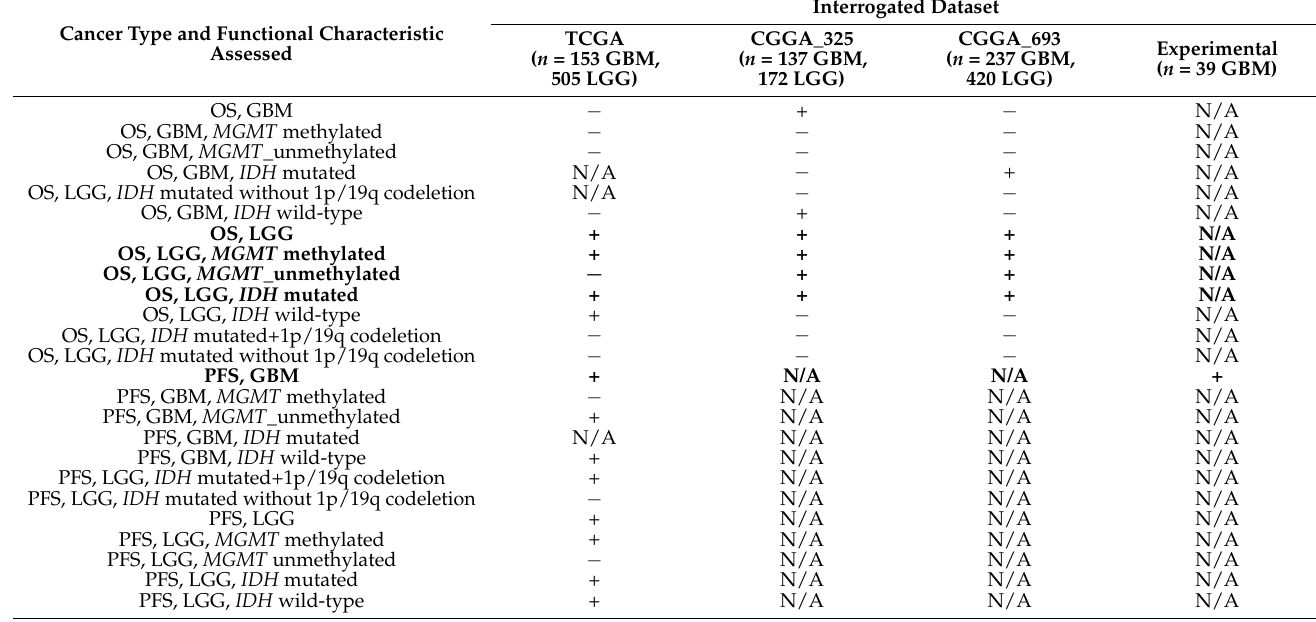
Table 2. Effectiveness of FREM2 pathway PAL2 as survival prognosis factor. “+” means statistically significant difference in comparison by the p -value of the log-rank test, “ − ” means non-significant comparisons. Positive results that coincide with the available datasets are